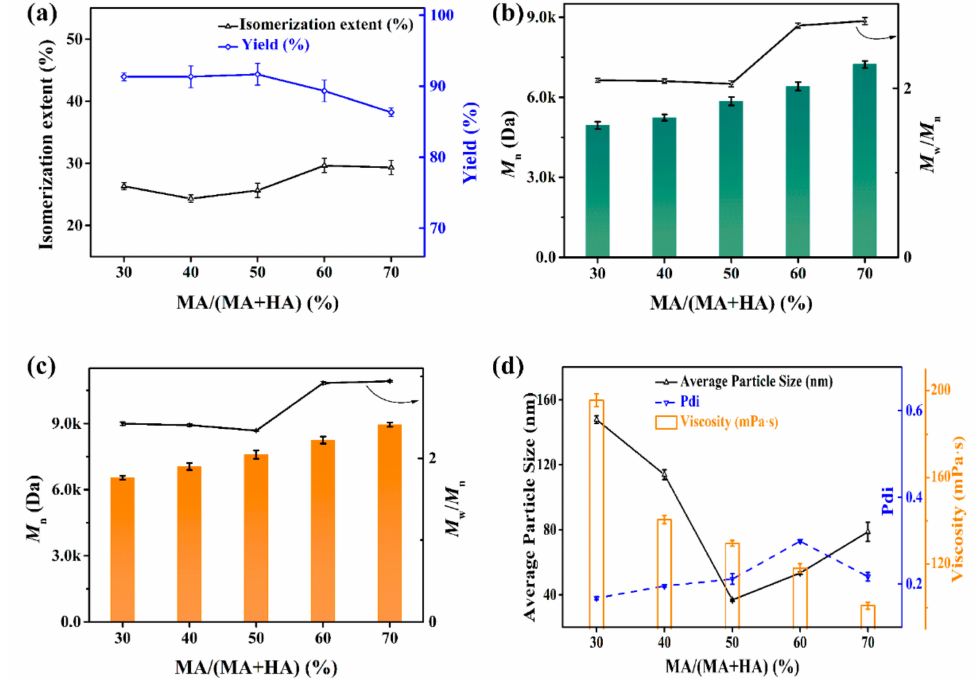
Figure 4. Isomerization extent and yield ( a ), M n and M w / M n of linear polyester ( b ) and comb-like polymer ( c ), particle size and viscosity ( d ) of polyester dispersions in different MA/(MA +